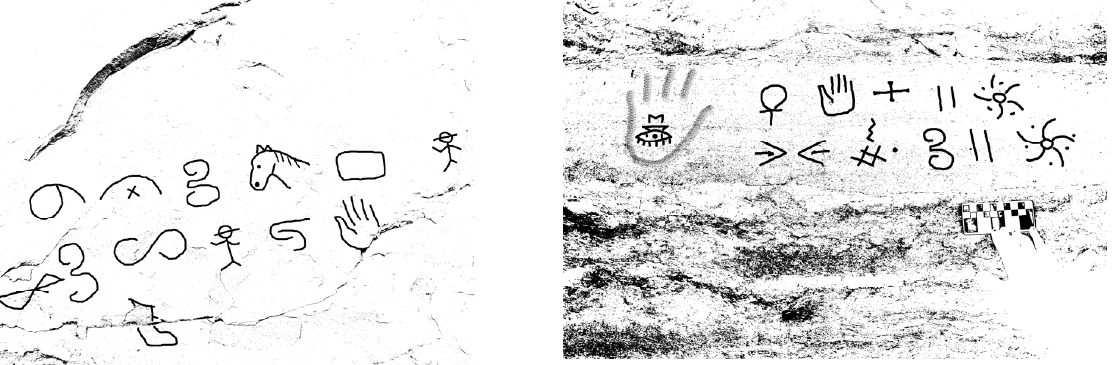
Figure 10. Tempe, Arizona. Panels 1 and 2. Digital photo enhancement with drawing on photo.